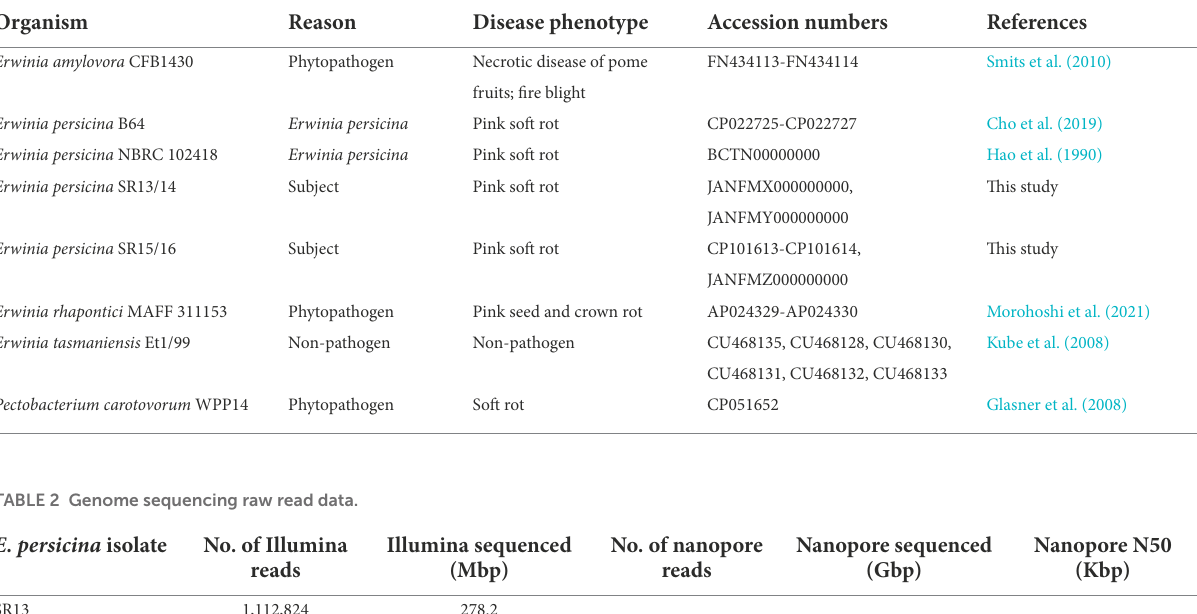
TABLE 1 Bacterial genomes used in protein comparisons.